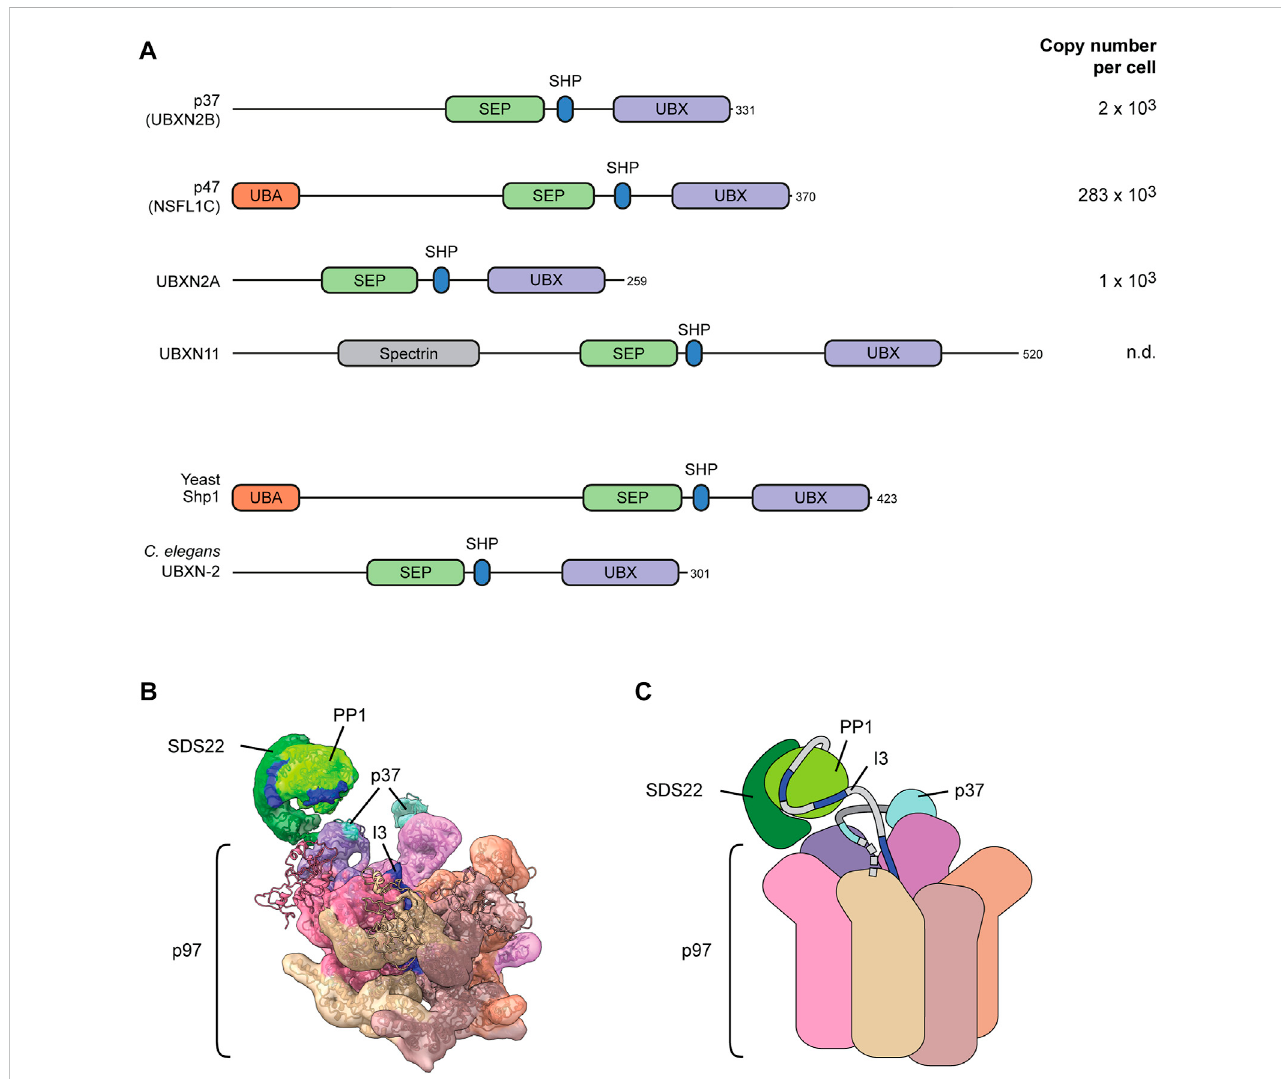
ortholog as depicted. The UBX domain and the SHP box motif mediate binding to the p97 N-domain. The de fi ning SEP domain contributes to a multivalent substratebindingmechanism.TheUBAdomainbindsubiquitin.CopynumbersofproteinsinhumanU2OSosteosarcomacellsaccordingto(Becketal.,2011). n.d.,notdetected. (B) Cryo-EMstructureofp97-p37-SDS22-PP1-I3.DarkblueindicatessectionsofI3insertedintothep97whilestillassociatedwithPP1 (brightgreen).NotedirectinteractionofSDS22(darkgreen)withanN-domain(purple)ofp97.TheSHPboxandUBXdomainofp37(cyan)bridgetwoadjacent N-domains. (C) Cartoon model of the structure in (B) . Dashed line indicates the N-terminal portion of p37 that is not resolved and includes the SEP